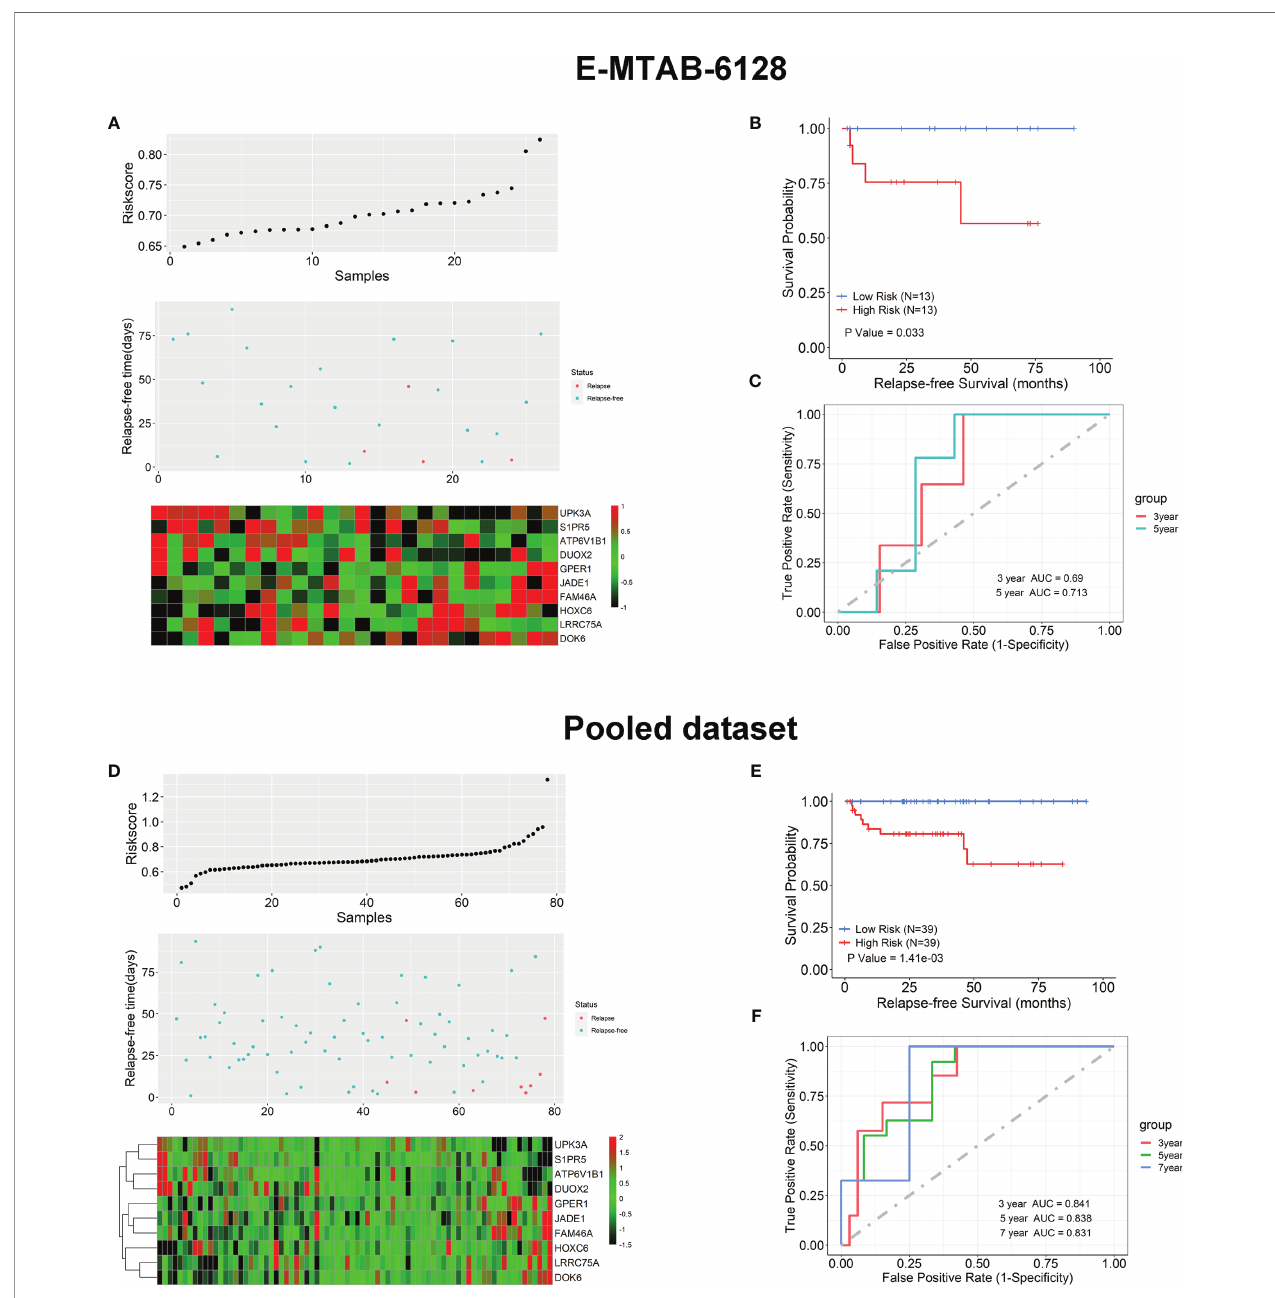
FIGURE 5 | External validation of the 10-gene prognostic model using independent test set (E-MTAB-6128) and the pooled dataset (TCGA and E-MTAB-6128). (A) The risk score, survival status, and expression levels of the 10 genes based on the TAN samples in E-MTAB-6128. (B) Kaplan-Meier survival analysis in terms of BCR-free survival for the high- and low-risk groups in the TAN samples of E-MTAB-6128 database. (C) The ROC analysis for the prediction of the 3- and 5-year BCR-free survival based on the risk scores calculated by the 10-gene model. (D) The risk score, survival status, and expression levels of the 10 genes based on the TAN samples in the pooled dataset. (E) Kaplan-Meier survival analysis in terms of BCR-free survival for the high- and low-risk groups in the TAN samples in the pooled dataset. (F) The ROC analysis for the prediction of the 3-, 5-, and 7-year BCR-free survival based on the risk scores calculated by the 10-gene